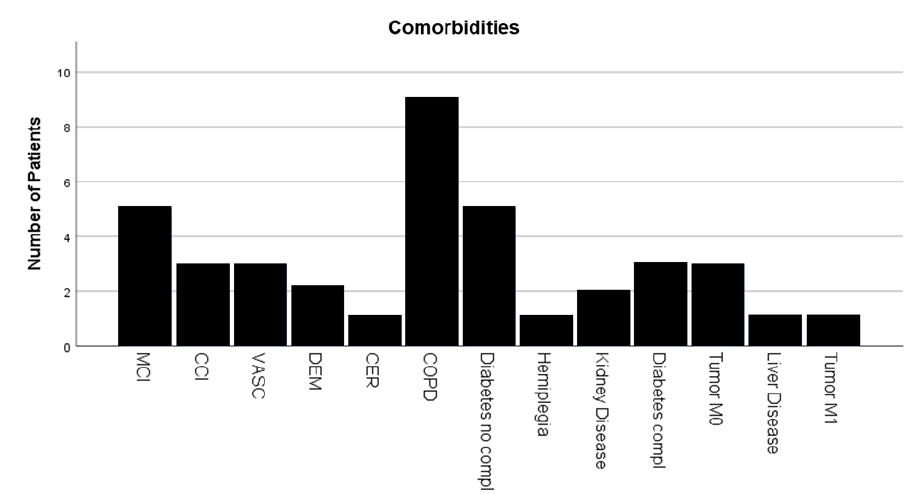
Figure 2. Number of Comorbidities. MCI = myocardial infarction; CCI = congestive cardiac insuffi- ciency; VASC = peripheral vascular disease; DEM = dementia; CER = cerebrovascular disease; COPD = chronic obstructive pulmonary disease; Tumour M1 = malignant tumour with metastasis.